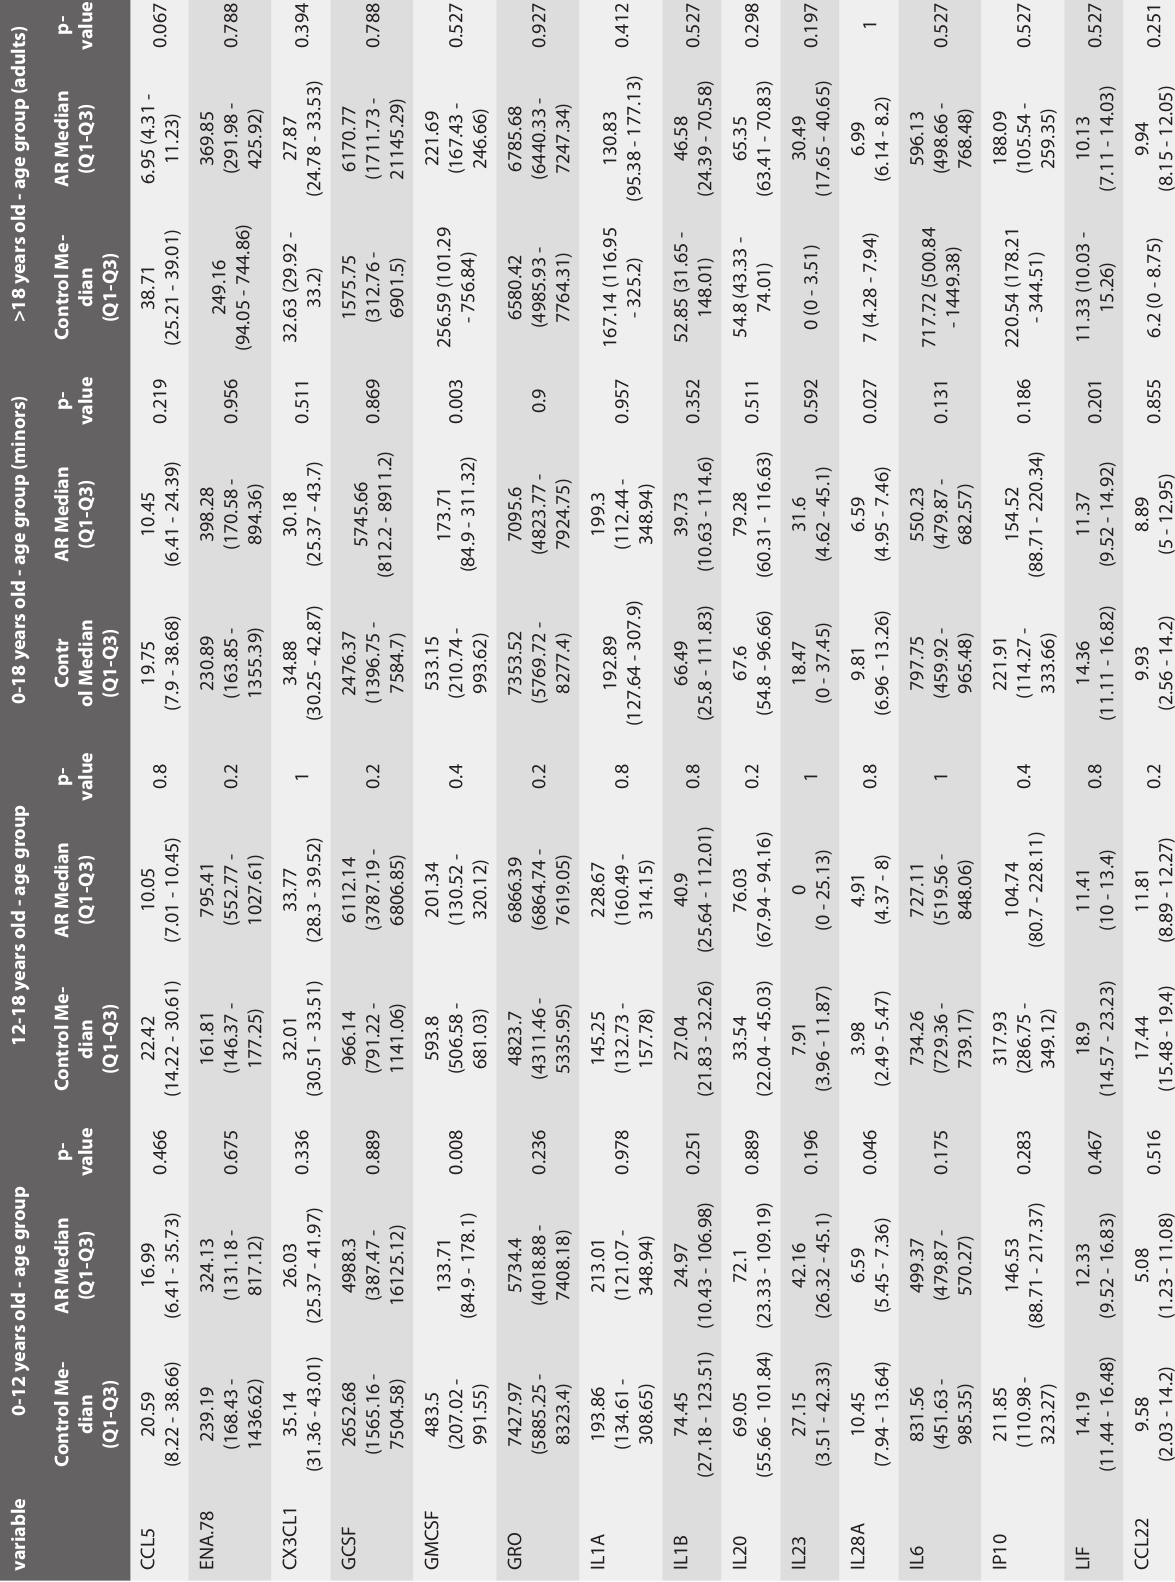
SUPPLEMENTARY Table S1. Comparing the protein expression levels between control and AR PNECs in different age groups (0-12, >12-18, <18 and > 18 years old); the comparisons have been performed with Wilcoxon’s rank-sum test, while descriptive statistics are given in the form of median (25th - 75th percentile).